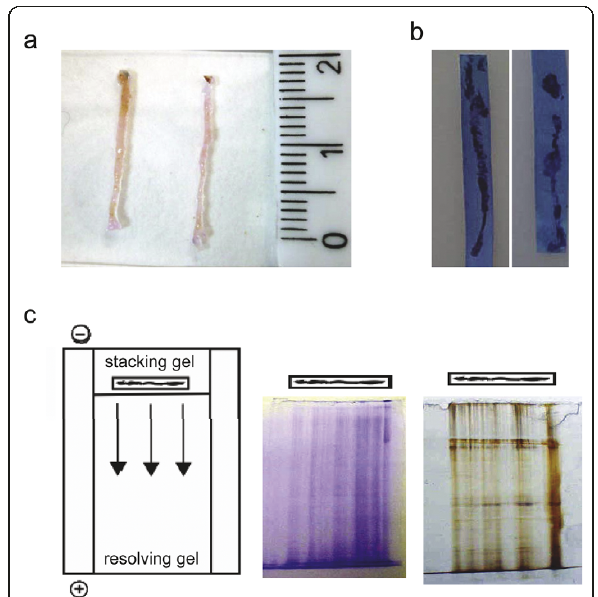
Figure 1 Tissue print and print-phoresis . (A) Photograph of two representative core needle biopsies. (B) The biopsy prints were incubated with 0.1% toluidine blue solution for five minutes. After two washing in phosphate buffer the prints were visualized as blue regions. (C) Schematic representation of the SDS-PAGE print- phoresis. Biopsy print has been put on the top of the resolving gel, and embedded in the stacking gel. Representative resolving gels were stained with Coomassie blue (left) or with silver solution (right) in order to visualize the protein content. On the top of each gel the position of the tissue print is